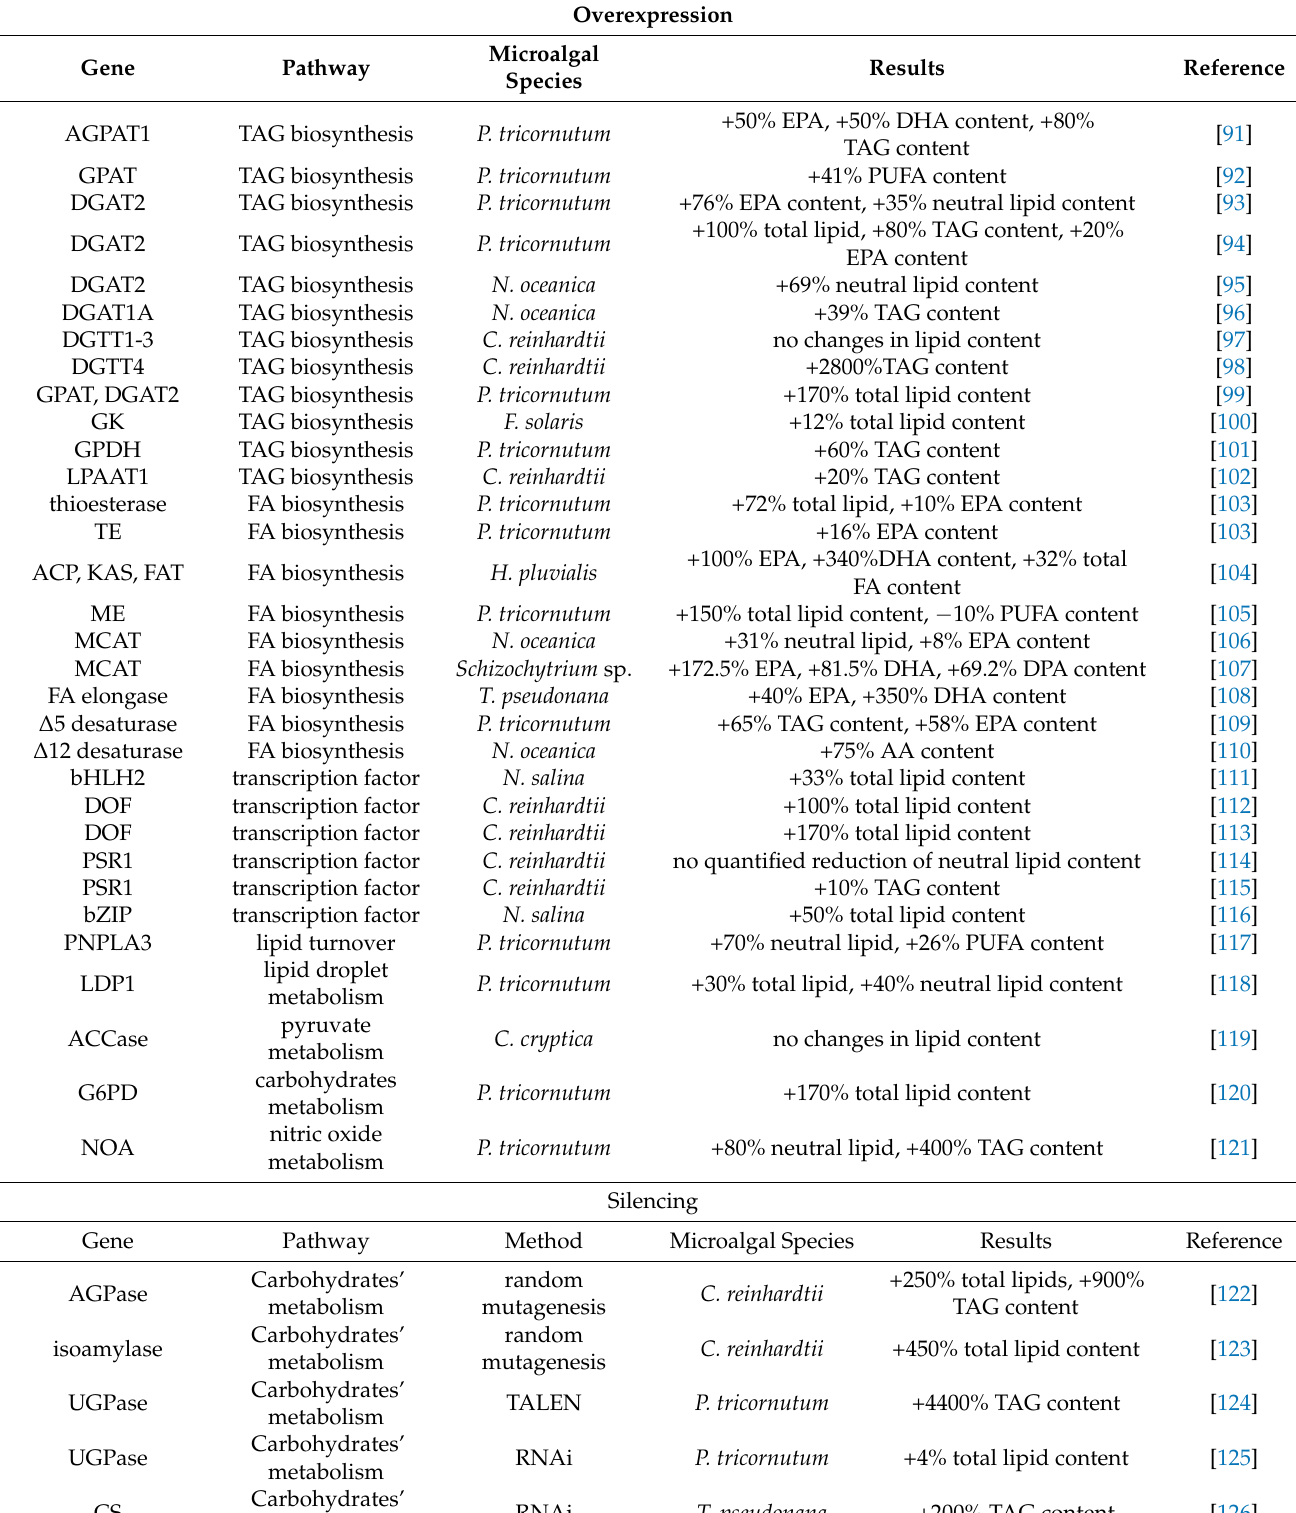
Table 2. Effect of different genetic modifications for enhancing PUFAs’ accumulation in microalgae. Studies are grouped by genetic modification, such as overexpression, silencing/knock-out, and heterologous expression, and then by the pathway in which the gene of interest is involved. The table represents the results obtained through specific genetic modifications. Genes and pathways are reported in Uniprot (https://www.uniprot.org/uniprot, accessed on 29 November 2021). Differences are shown as percentage increases, indicating the surplus over the wild-type control